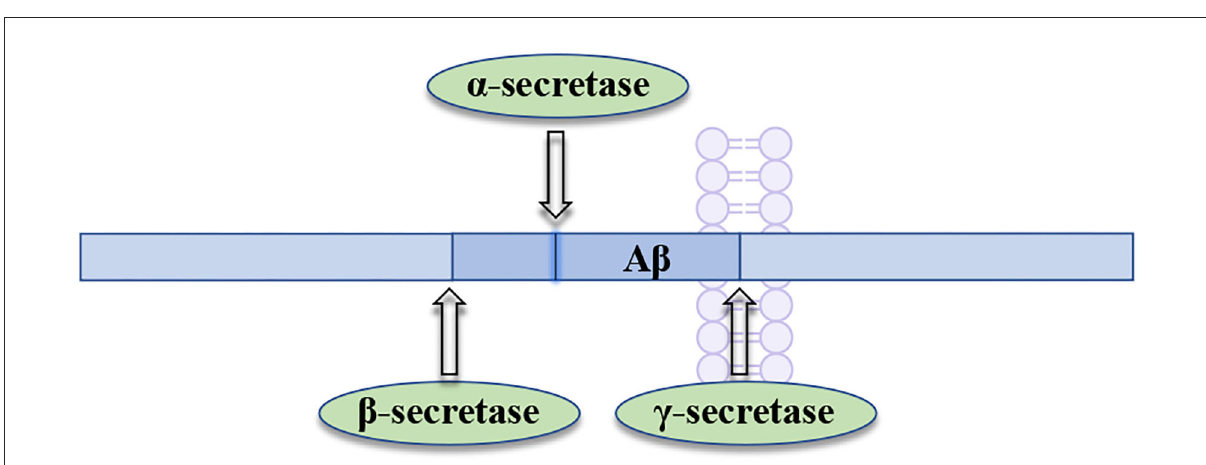
FIGURE4 Processing of amyloid precursor protein (APP) by β -secretase and γ -